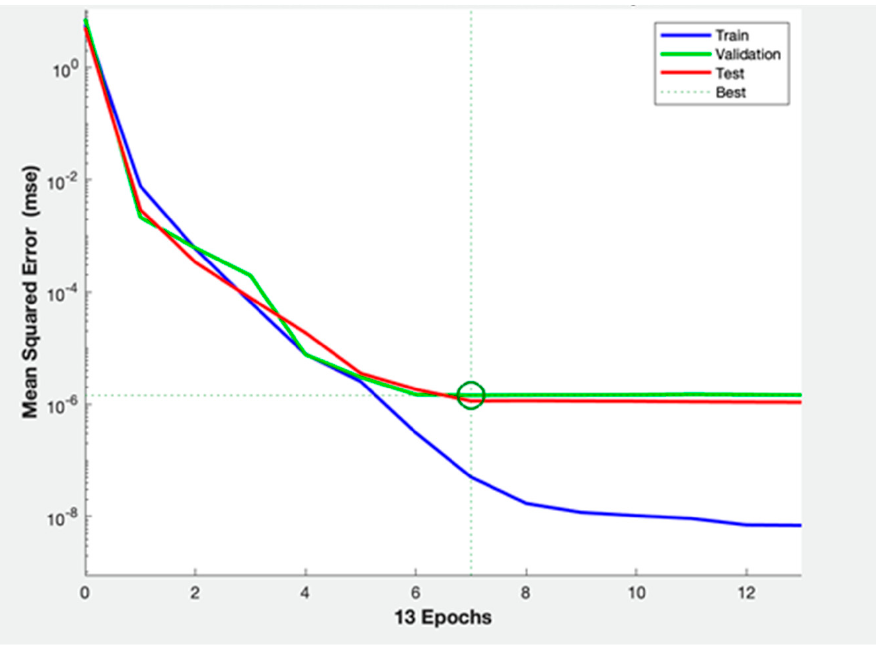
Figure 4. The Neural Network performance plot shows that overfitting and underfitting are irrele- vant in our set. 1.4331 × 10 − 6 is the best performance value. in our set. 1.4331 × 10 − 6 is the best performance